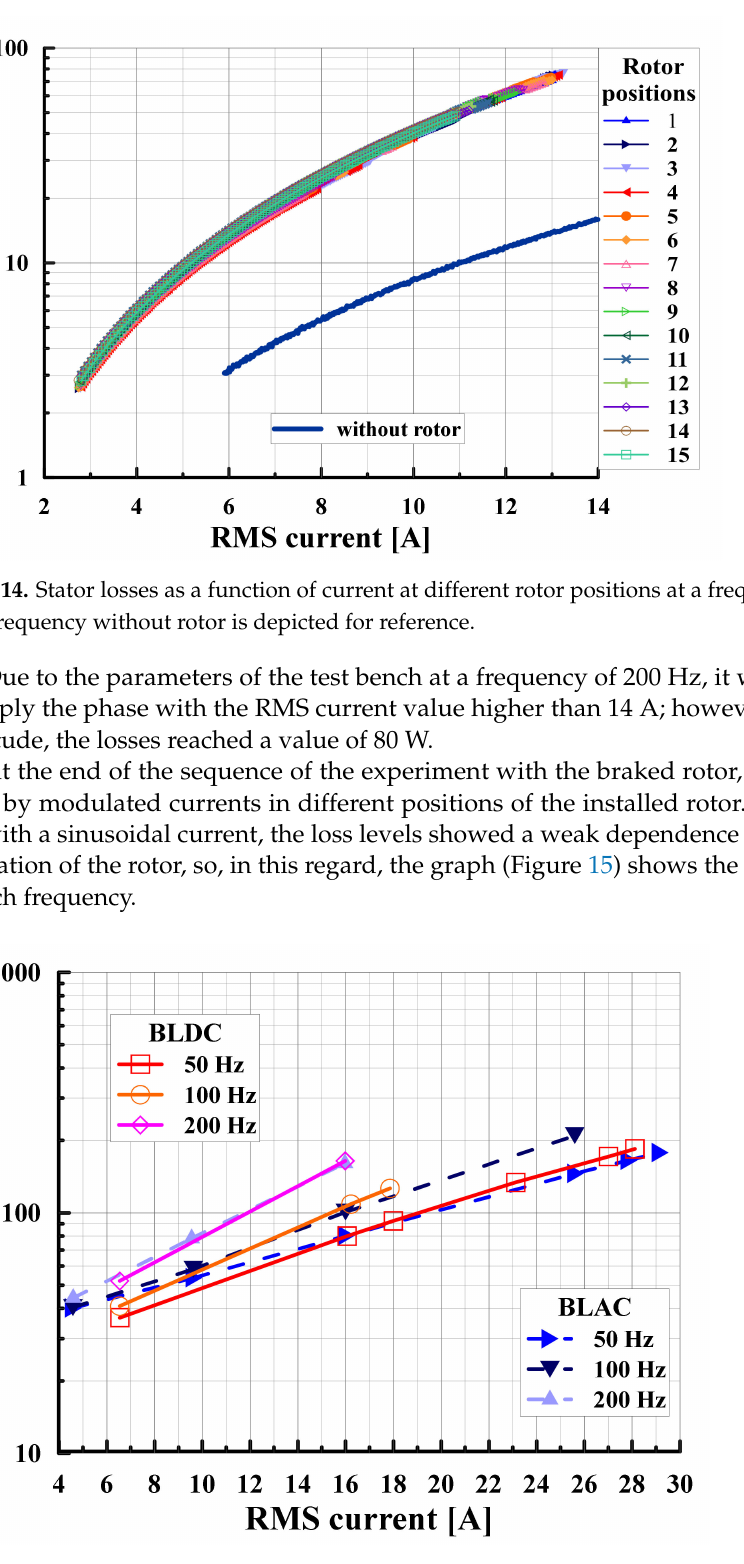
Figure 15. Averaged (for positions 0, 8, 15) stator losses on modulated current waveforms as a function of